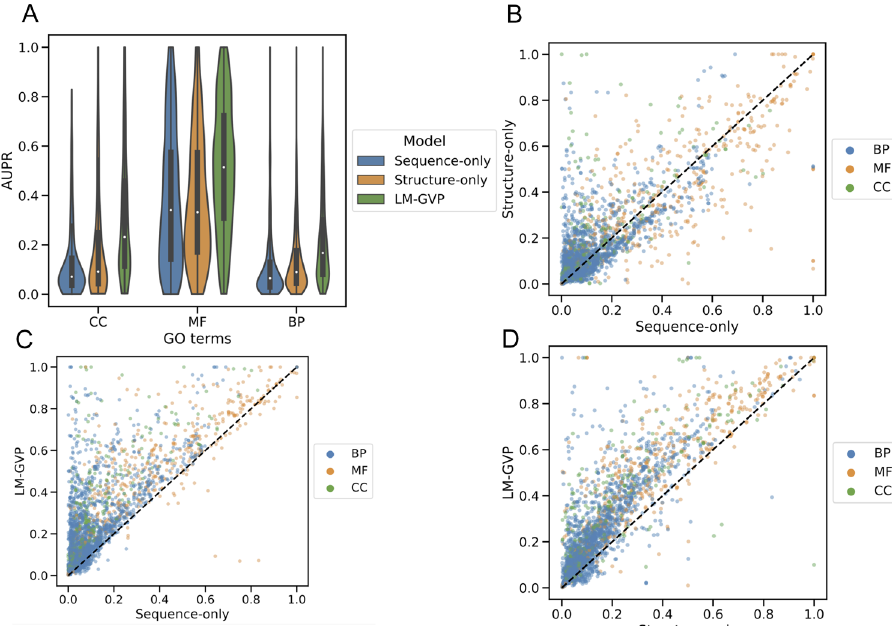
Figure 2. Distribution of model performance across individual GO terms. ( A ) Violin plots showing the distribution of area under the precision recall curve (AUPR) over subsets of GO terms predicted by different models. ( B – D ) Scatter plots of AUPR values across GO terms from different models. Each dot in the plots corresponds to an individual GO term, colored by its subset indicated in the legend. BP biological process, MF molecular function, CC cellular